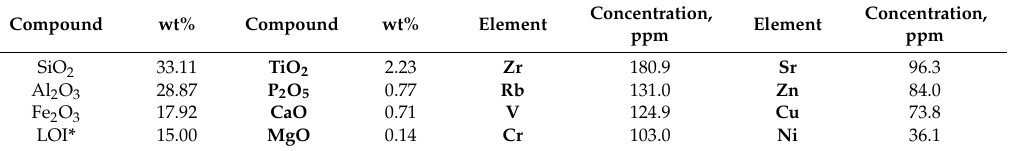
Table 2. Chemical composition and trace elements of halloysite (based on